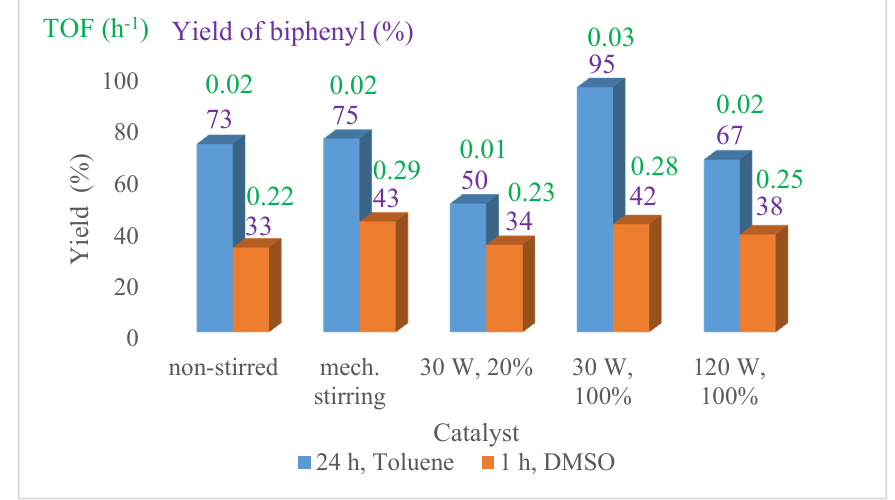
Figure 7. The biphenyl yield in the reaction of iodobenzene and phenylboronic acid in toluene after 24 h (blue) and in DMSO after 1 h (red) with the selected NiNPs samples at reflux temperature.